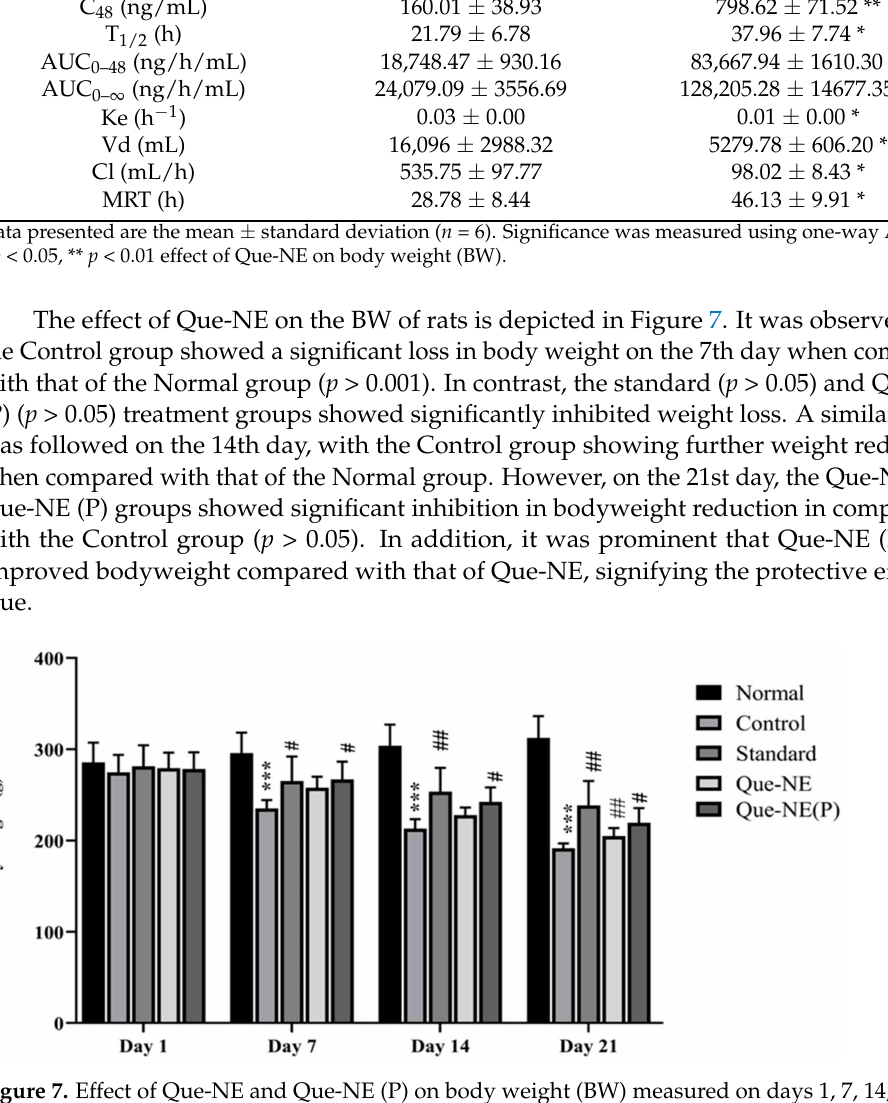
Figure 7. Effect of Que-NE and Que-NE (P) on body weight (BW) measured on days 1, 7, 14, and 21 of treatment. Data presented are the mean ± standard deviation. Significance was measured using one-way ANOVA. *** p < 0.001 vs. Normal group. # p < 0.05 and ## p < 0.01 vs. Control group ( n =